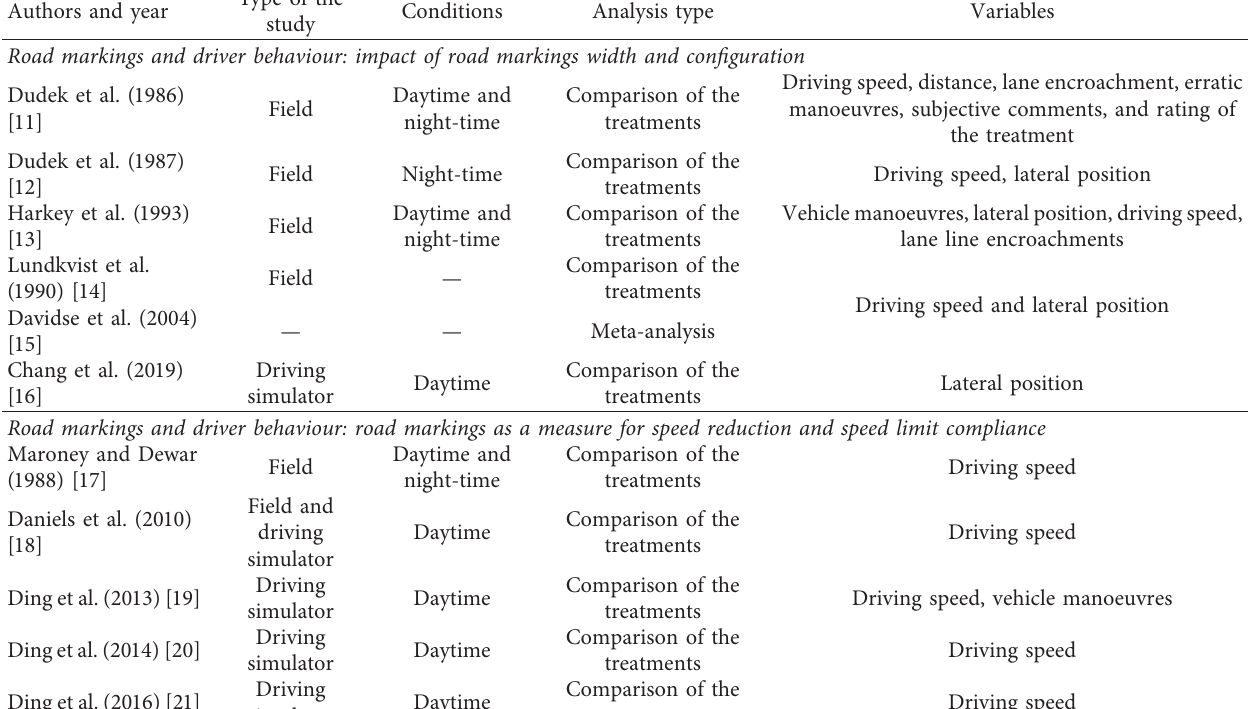
Table 1: Summary of the studies related to the impact of road markings on driver